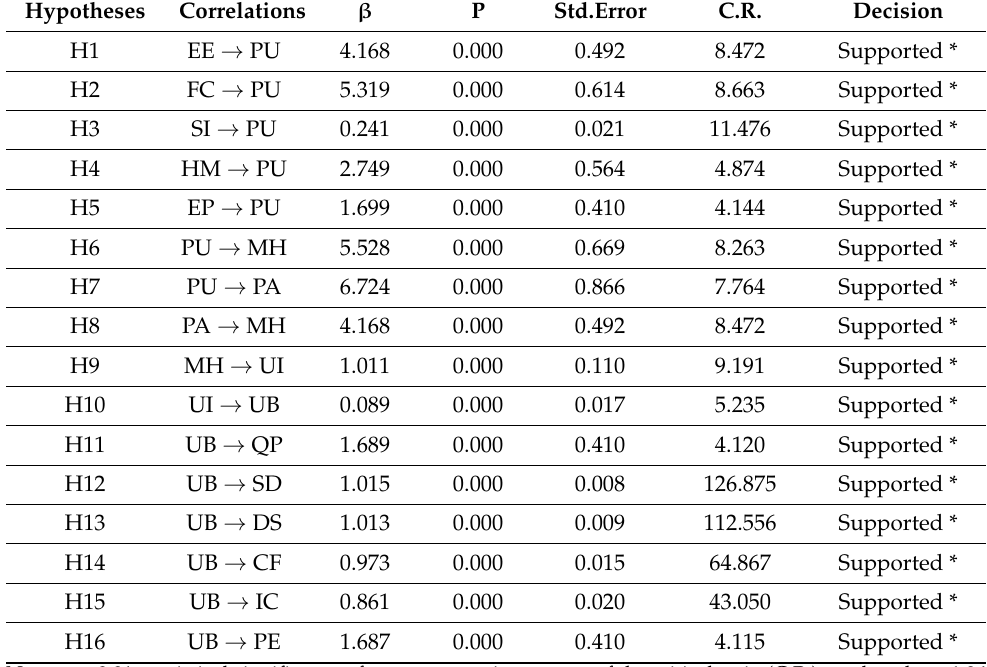
Table 4. The structural model